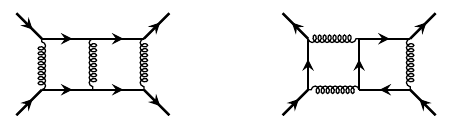
Figure 3. The two two-loop masters with external